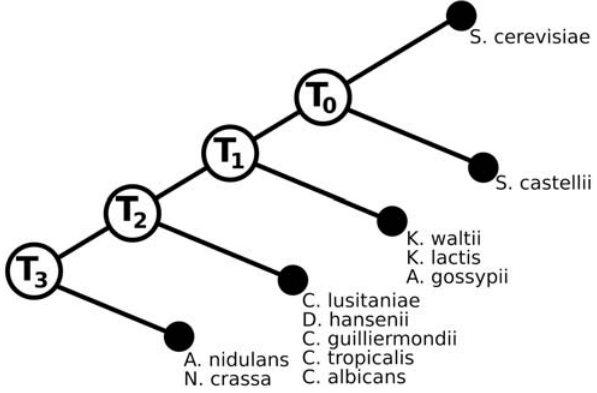
Figure 5. A fungal phylogenetic tree showing ancestral species nodes into which Saccharomyces cerevisiae duplicates are grouped ( T 0 – T 3 ). Groupings were generated from gene trees reported in reference [28]. Ancient duplications occurred in ancestral node T 3 and the most recent duplications occurred in T 0 .